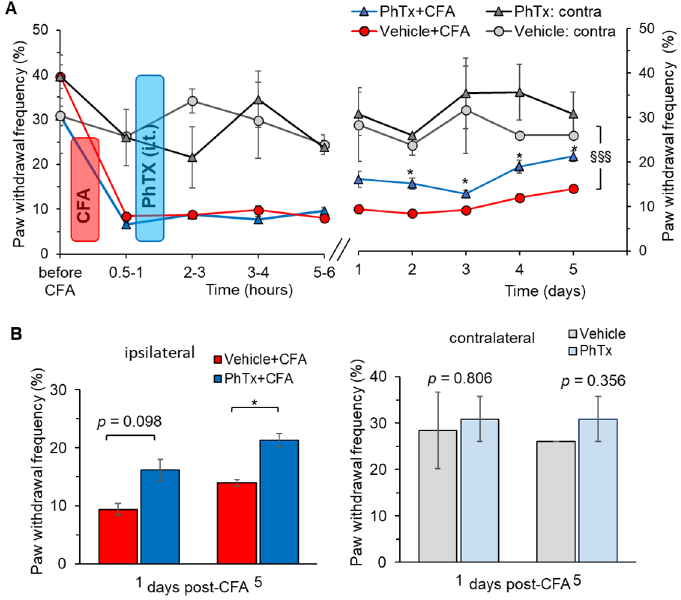
Figure 9. Selective inhibition of Ca 2+ -permeable AMPARs in the spinal cord alleviates inflammatory pain of mechanical modality in rats with peripheral inflammation. ( A ) The time course of changes in the paw withdrawal frequency—the mechanical nociceptive threshold—following inhibition of Ca 2+ -permeable AMPARs with philantotoxin − 74 (PhTx, 1 µ M), given intrathecally (i.t.) after the development of inflammatory-induced peripheral mechanical hypersensitivity. The experimental scheme was as shown in Figure 8A. The withdrawal frequency normalised to maximum response (100%). * p < 0.05 compared to the corresponding time in the CFA-inflamed group without PhTx; §§§ p < 0.001 compared to the corresponding time on the contralateral (non-inflamed) side. ( B ) Sum- mary of the paw withdrawal frequency on days 1 and 5 after CFA. * p < 0.05 versus as indicated. Pain relief remained stable over the next tested days ( p < 0.05; Figure 9A).